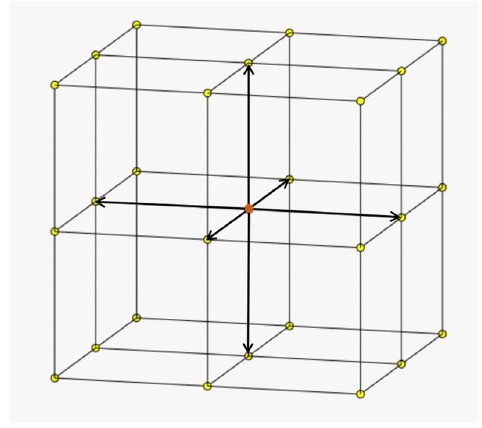
Figure 3. Motion directions of the UAV.